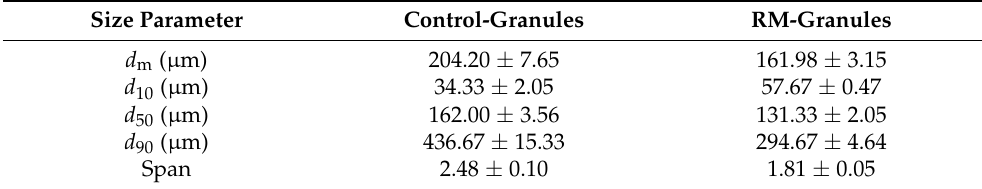
Table 2. True density ( ρ true ), loose bulk density ( ρ lb ), tapped bulk density ( ρ tb ), Carr compressibility index (CI), and Hausner ratio (HR) of SD powder, Control-granules, and RM granules.